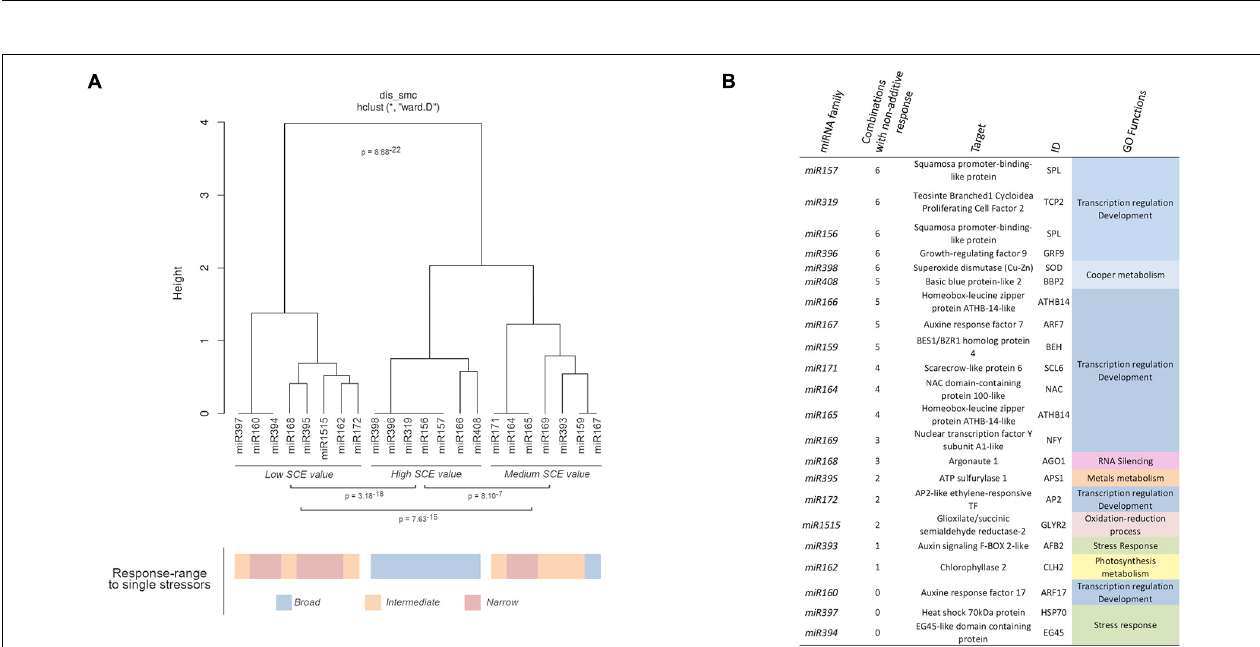
FIGURE 5 | Biological functions of miRNAs with non-additive response to combined stresses. (A) Dendrogram showing the clustering of miRNAs families with at least a member with significant non-additive response to combined stresses in three main groups according to their SCE values in the analyzed stress conditions. The global statistical significance of the identified clusters ( p = 8.88 × 10 – 22 ) was estimated by Mann–Whitney–Wilcoxon test, considering the inter- and intragroup Euclidean distances. The lower panel shows the response range determined for each miRNA family in response to single stresses with both biotic and abiotic sources (using a color scale). (B) Description and detailed information of the targets for miRNAs with significant non-additive response to combined stresses identified in melon plants. The GO terms were estimated in a base to information of homologous transcripts in A. thaliana .